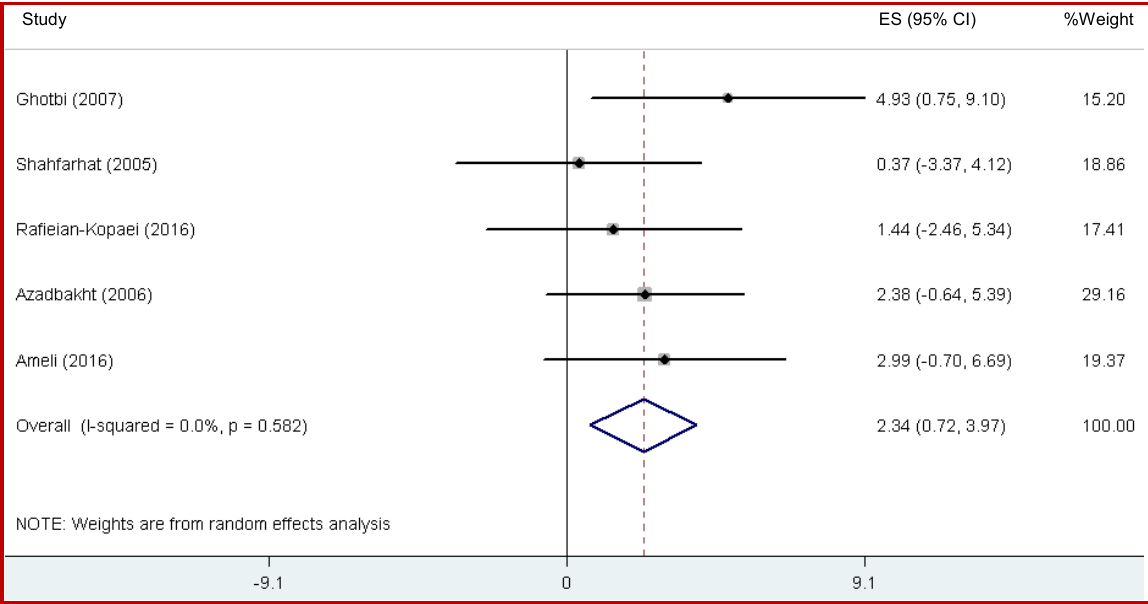
Figure 6: Forest plot Standardized Mean Change (SMC) of between 2 arms (intervention-comparison) in 36 hours after the inter- vention versus baseline